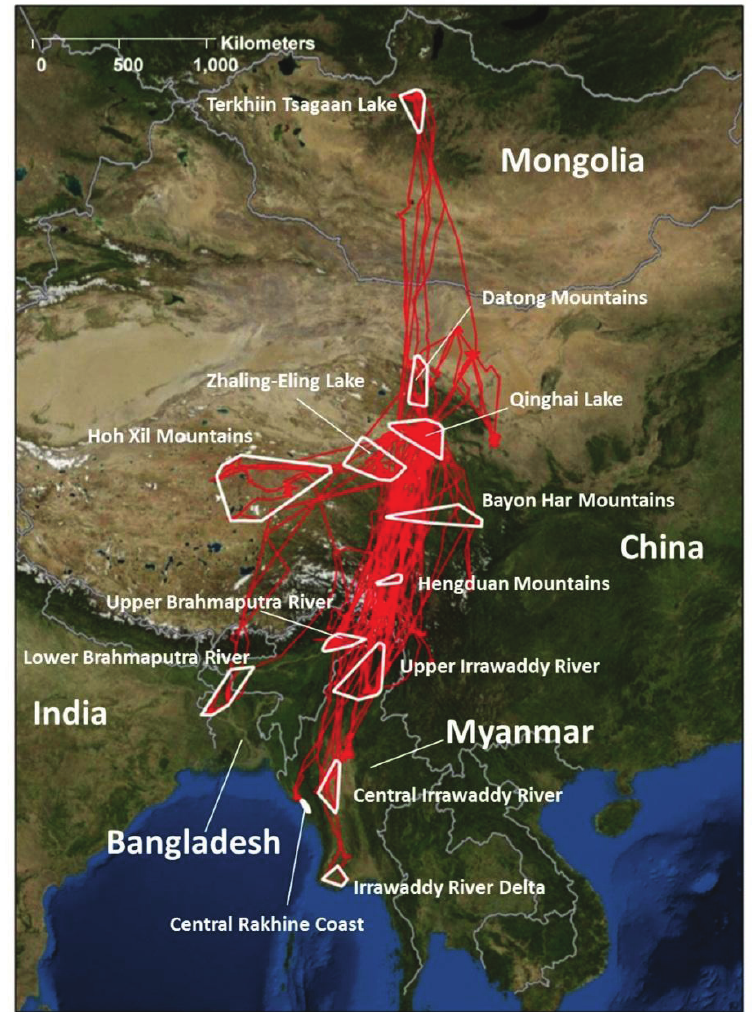
Figure 1. General movement patterns for 26 ruddy shelducks marked with satellite transmitters at Qinghai Lake, China. Study area and movement paths (red lines) for 26 ruddy shelducks marked with satellite transmitters in 2007 – 2008 and tracked through 15 May 2010. White polygons represent Minimum Convex Polygons (MCP) encompassing locations at breeding, wintering and stop-over